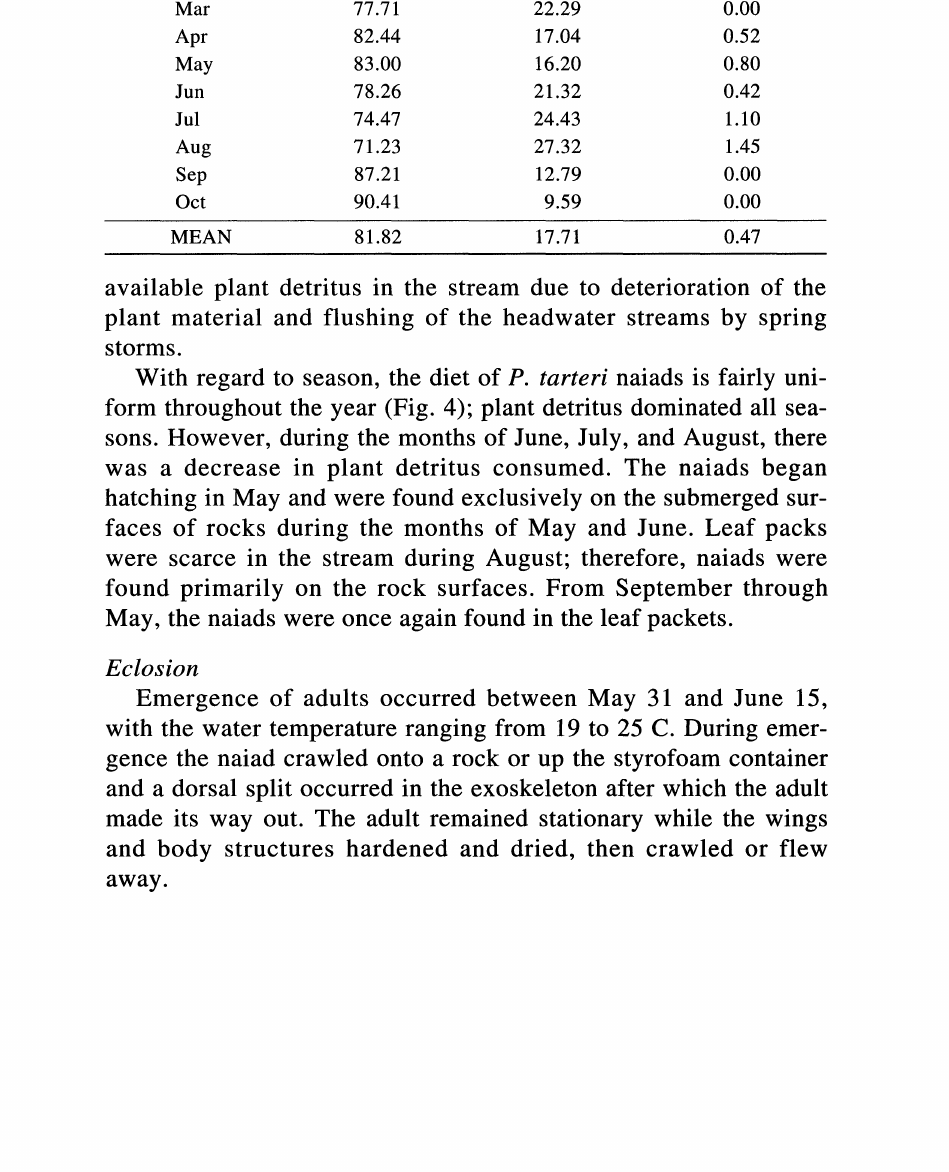
Table 1. Percentage composition of foregut contents of naiadal Peltoperla tarteri, at Big Hollow, November 1988-October